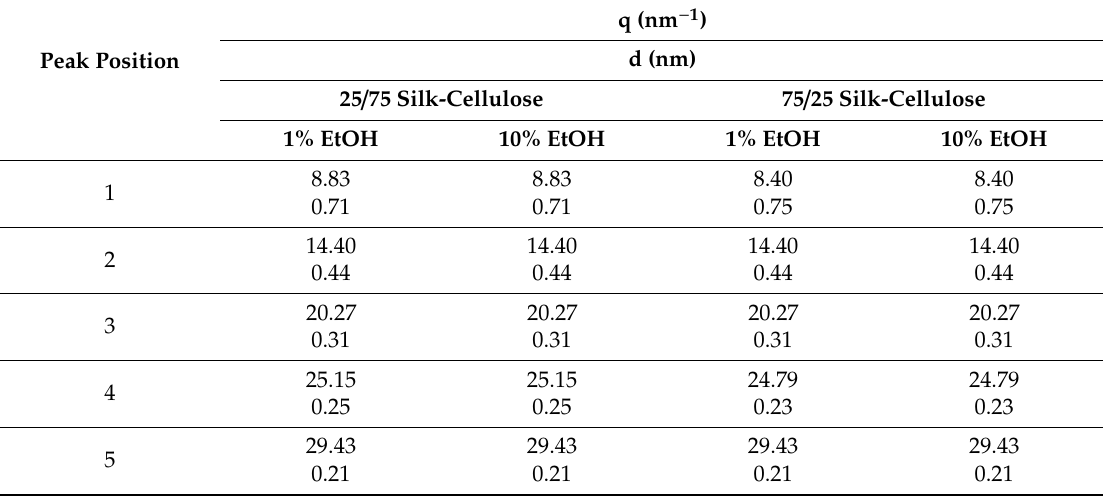
Table 4. Scattering vector and correlation distances for two varied composition silk / cellulose biocomposites coagulated with two di ff erent coagulation agents.